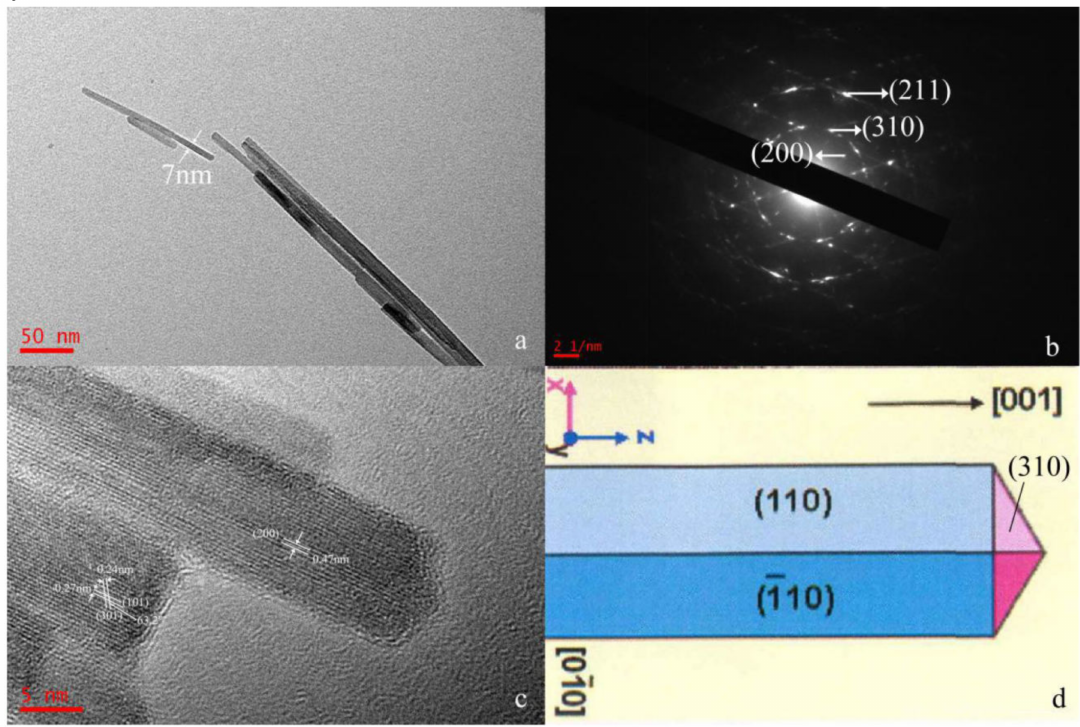
Figure 5. TEM of OMS-2 (( a ) TEM, ( b ) SAED, ( c ) HRTEM, ( d ) OMS-2 nanorod